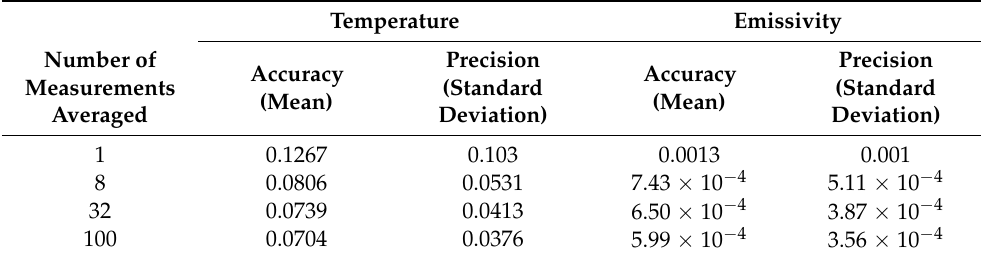
Table 1. Calibration of accuracy and